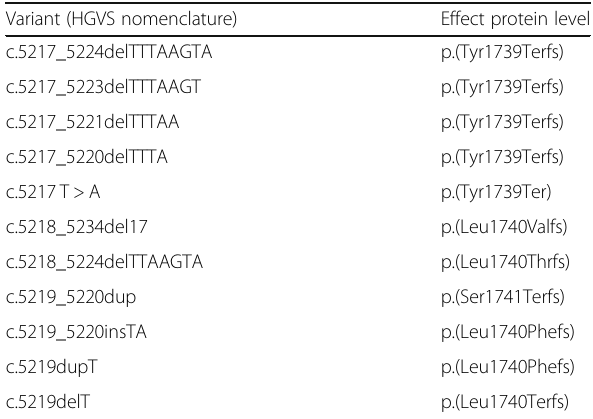
Table 3 Reported pathogenic variants in ClinVar at nucleotide 5219 or surrounding this position in BRCA2 gene (RefSeq